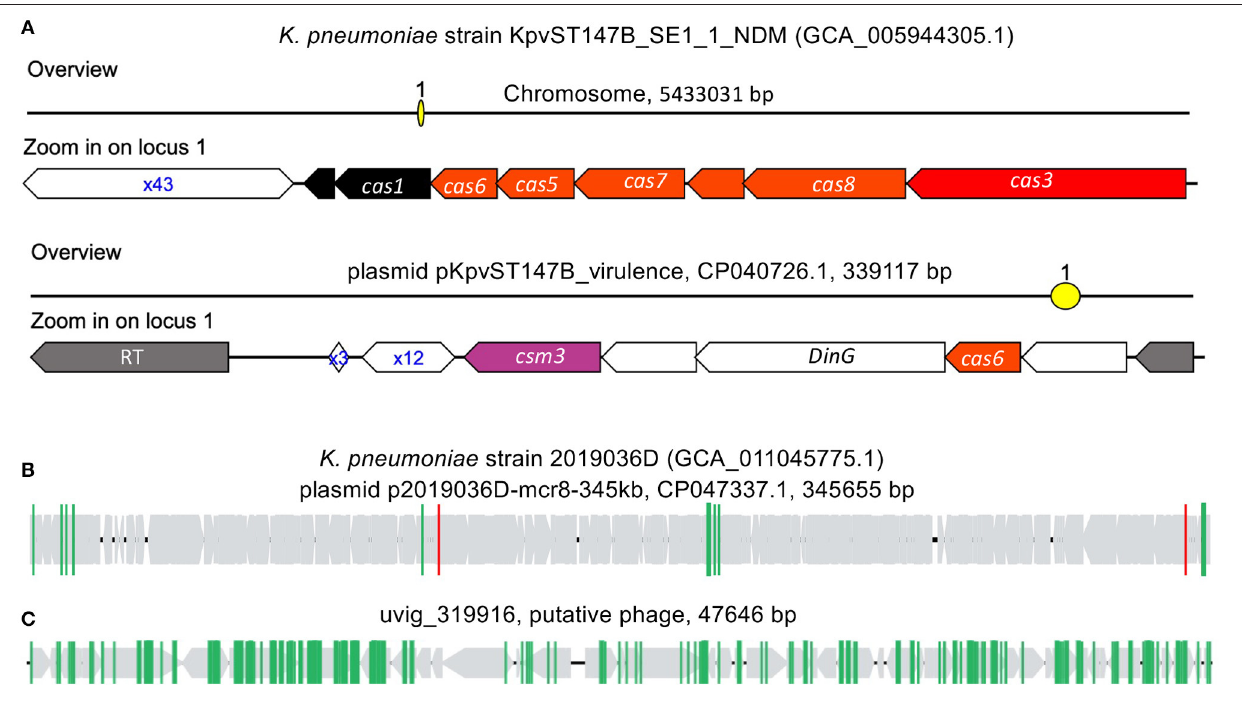
FIGURE 6 | CRISPR–Cas systems in K. pneumoniae genomes. (A) type I-E CRISPR–Cas system found in the chromosome of K. pneumoniae strain KpvST147B_SE1_1_NDM, and the other CRISPR–Cas (likely type IV) in the plasmid. (B,C) are selected examples of plasmid (B) and phage (C) invaders that contain protospacers matching spacers found in K. pneumoniae ’s CRISPR–Cas systems. In (B,C) , the gray arrows represent the genes predicted in the invaders, and the vertical lines each represent a